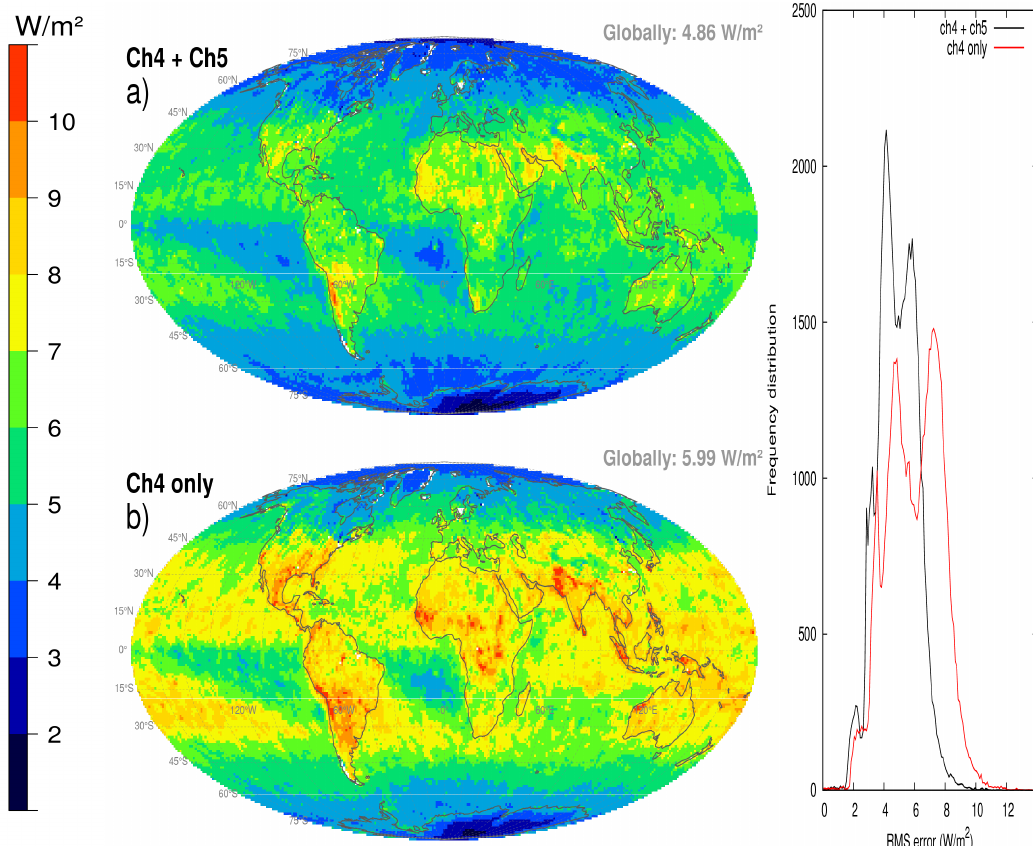
Figure 2. Regional variation of the RMS error (Wm − 2 ) in 1 ◦ × 1 ◦ latitude-longitude boxes. ( a ) is for the two channel regression (Equation (1)) and ( b ) when Channel 5 is not available (Equation (2)). The histograms are also given